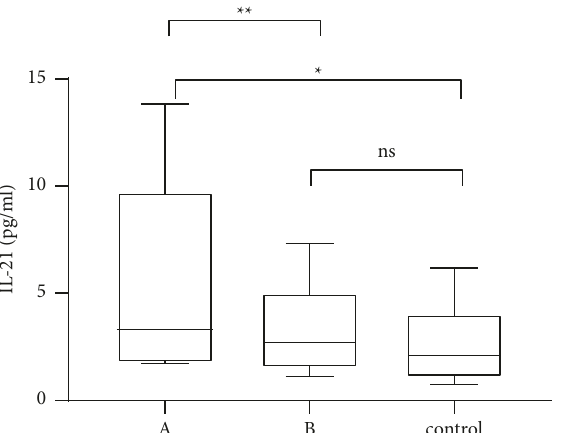
Figure 3: Interleukin-21 (IL-21) levels in AIH patients with elevated serum IgG4 (A), AIH patients with normal serum IgG4 (B), and healthy controls measured by ELISA.